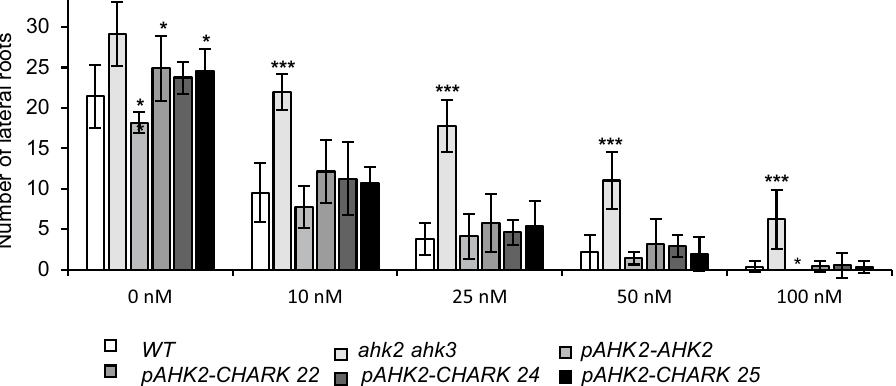
Figure 6. CHARK mediates suppression of lateral root formation by cytokinin. The number of lateral roots of seedlings grown on medium supplemented with 0, 10, 25, 50, or 100 nM iP was counted 12 days after germination. The experiment was repeated three times. Data represent mean values ± SD ( n = 10). The significance of differences compared to WT was calculated using Student’s t-test. * P < 0.05; ** P < 0.01; *** P < 0.001.